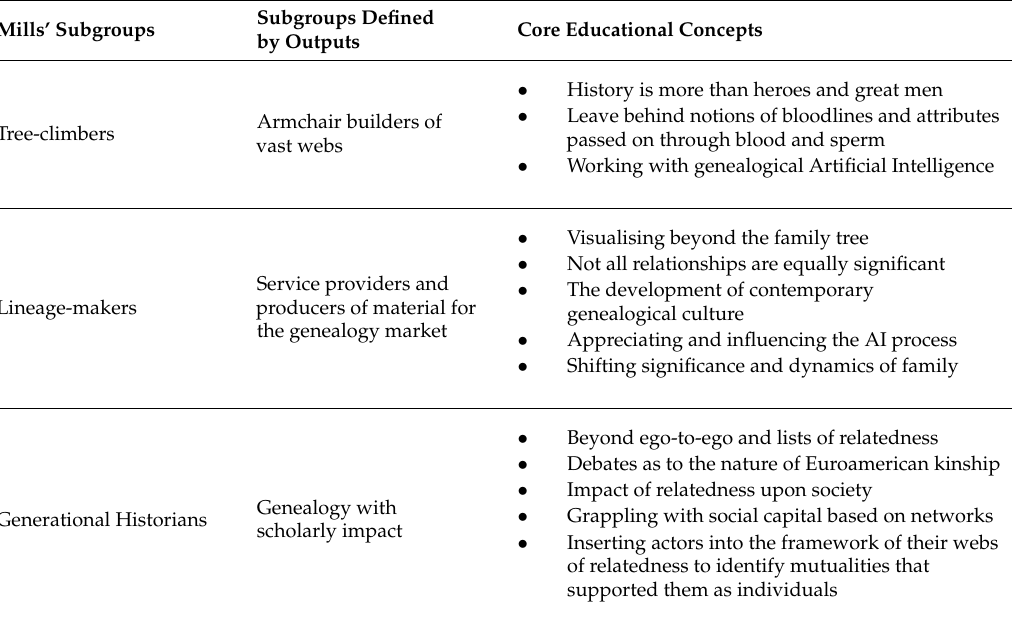
Table 1. Additional educational needs of genealogy based upon outputs of genealogical